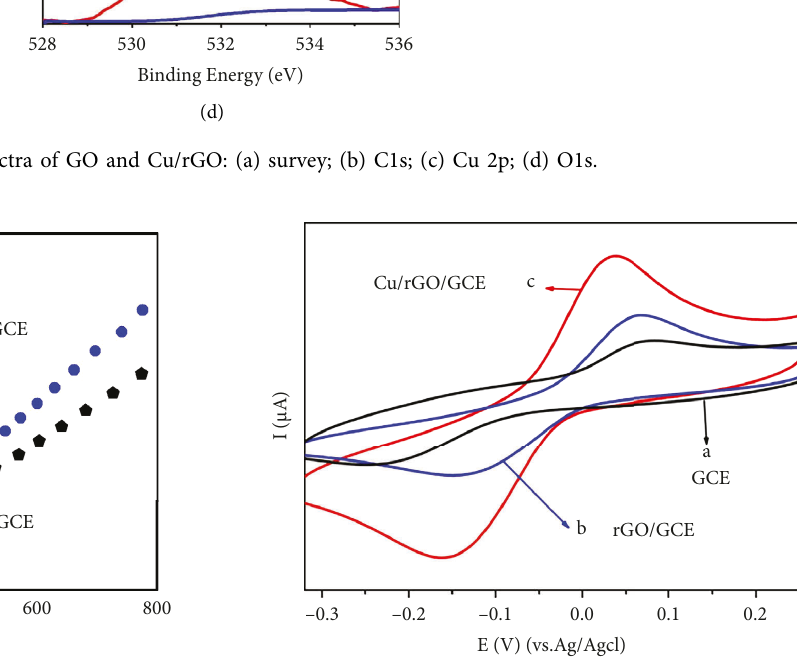
Figure 5: CV of GCE (a), rGO/GCE (b), and Cu/rGO/GCE (c) in PBS containing 5.0 μ M HQ; scanning rate, 120mV · s − 1